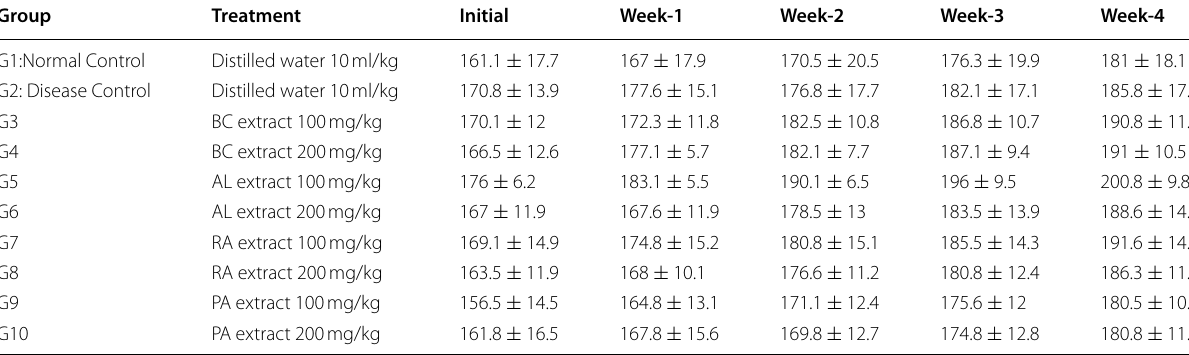
#: p < 0.05 when compared to G1 Normal Control; *: p < 0.05 when compared to G2, Disease control Table 5 Effect of extracts on serum biochemistry in ethylene glycol induced urolithiasis in rats